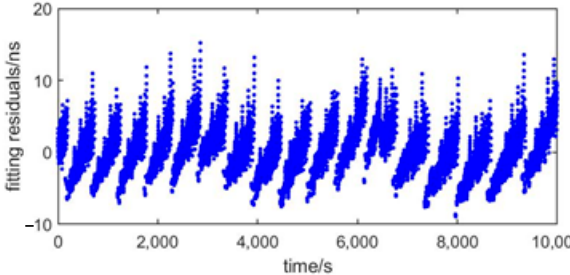
Figure 5. RDSS one-way timing error (remove orbit period).